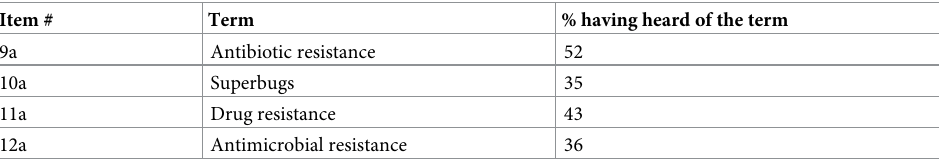
Table 6. Participant awareness of terms associated with antibiotic resistance.